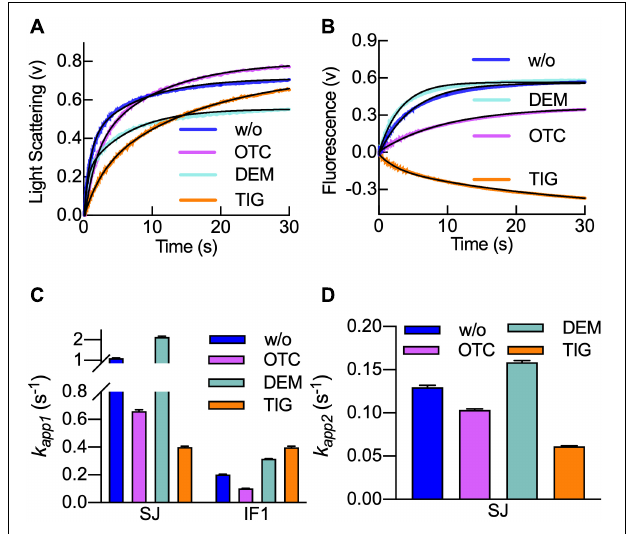
FIGURE 4 | Tigecycline delays 70S IC formation and hampers IF1 dissociation. (A) Light scattering time courses of 0.1 µ M 30S IC binding to 0.15 µ M 50S in the absence of tetracyclines (blue) or the presence of Otc (pink), Dem (aquamarine), or Tig (orange). (B) Time courses of IF1 540Q dissociation during 70S IC formation as measured by FRET from fMet-tRNA fMet (Flu). Colors and concentrations are as in panel (A) . Bar-graph comparing the apparent rates k app1 (C) of subunit joining and IF1 dissociation and k app2 (D) for subunit joining. Colors in panels (C,D) are as in panel (A) . Shown time courses result from six to eight averaged replicates. Continuous black lines in panel (A) represent the non-linear fitting with a double exponential term equation (Eq. 2), while in panel (B) , a single-step model applied for IF1 540Q dissociation was used (Eq. 1). Error bars in panels (C,D) indicate standard errors of the